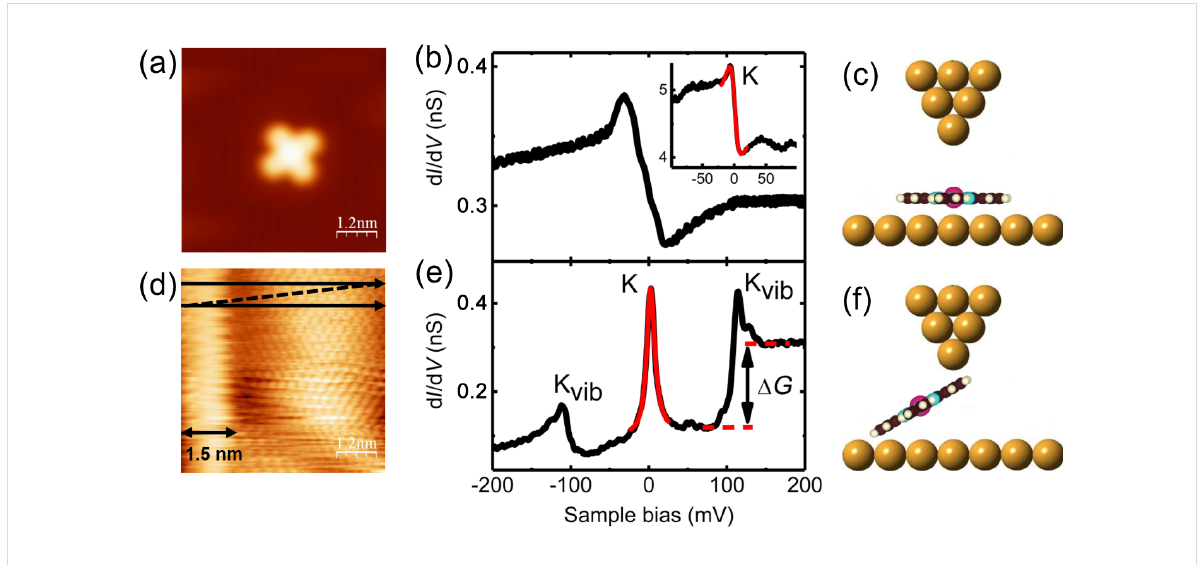
Figure 2: (a) STM image (0.3 nA, − 0.3 V). (b) d I /d V spectrum of a flat-lying MnPc molecule on the Au(111) surface (0.01 nA, − 0.3 V). The inset shows a high-resolution spectrum (0.1 nA, − 0.1 V) taken with a modulation of 1 mV (rms). The red curve is a Fano line fitted to the Kondo resonance labeled with K. (c) Schematic view of the STM junction for (b). (d) STM image of the bare Au(111) surface with the MnPc-terminated tip (0.1 nA, − 0.3 V). The black arrows indicate the raster-scan direction during the STM imaging process. The scanning speed of the MnPc-terminated MnPc tip over the bare Au(111) surface is 19 nm/s, much slower than the one of 76 nm/s in (a). The black double arrow at the bottom-left indicates the width of the bright vertical stripe. (e) d I /d V spectrum obtained with the MnPc-terminated tip over the bare Au(111) surface (0.1 nA, − 0.25 V). The